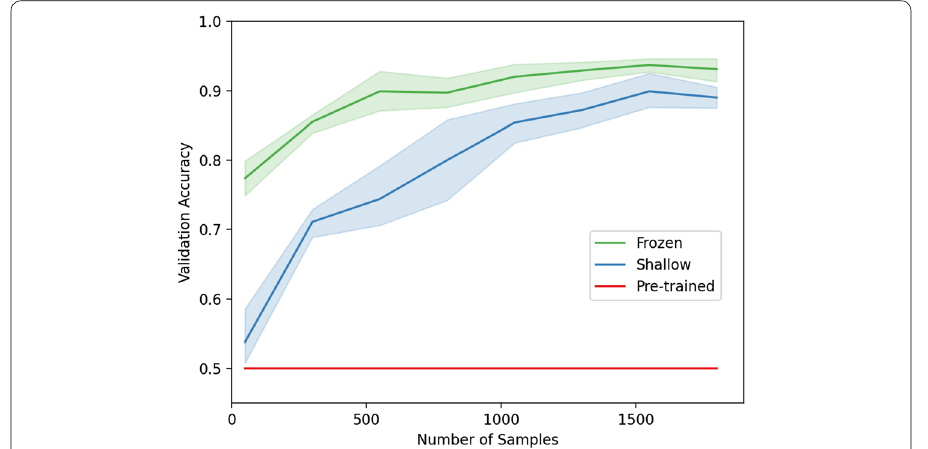
Fig. 2 Displayed above is the number of training samples from each category, from 50 to 1800, vs the validation set accuracy achieved by each model. For robustness, 5 trials were run for all training samples tested. The color bands indicate the distribution of results from the 5